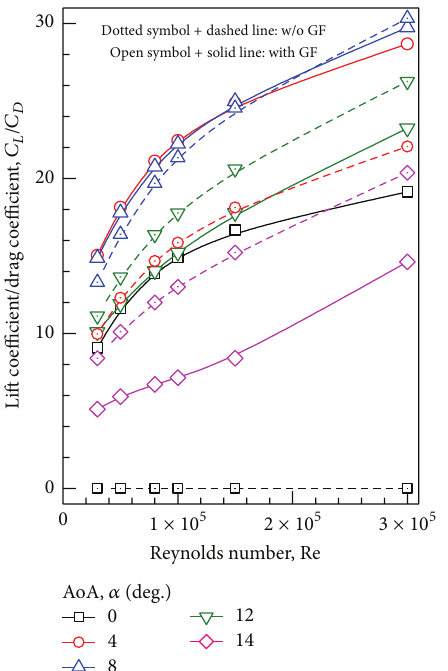
Dotted symbol + dashed line: w/o GF Open symbol + solid line: with GF